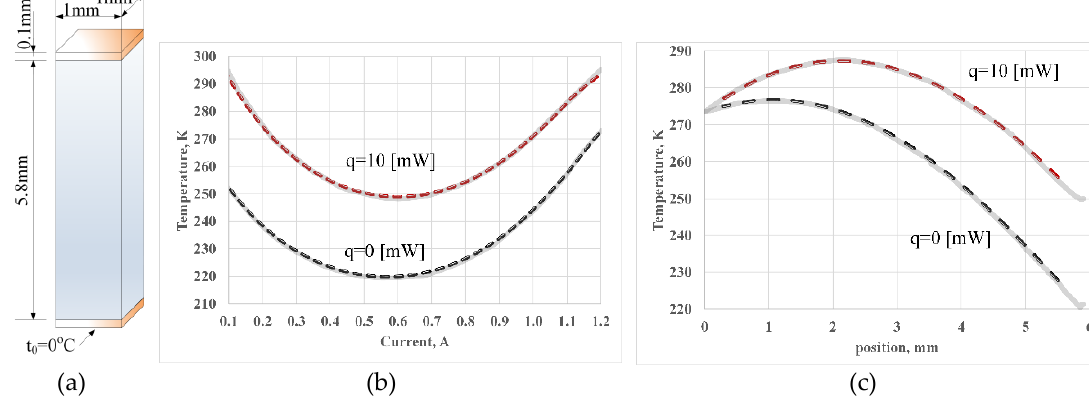
Figure 15. ( a ) A p-type thermoelectric element is contacted by copper electrodes, and steady-state simulation results: ( b ) the cold side temperature vs. current with and without thermal load, and ( c ) temperature distribution along the element calculated without and with a 10 mW heat load. The results obtained as a result of simulation by the proposed method are shown with dashed lines. The gray solid lines are taken for comparison from [33]. Table 4. Temperature dependent material properties of (Bi 0.5 Sb 0.5 ) 2 Te 3 from